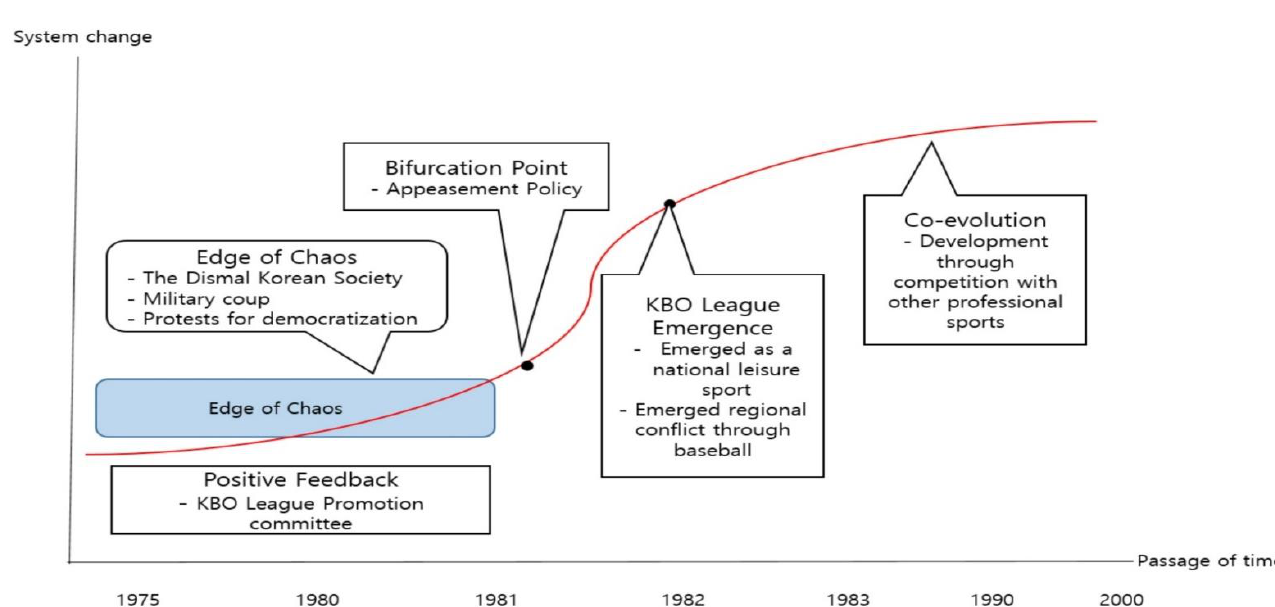
Figure 1. The emergence process of the KBO league from the perspective of the complex system paradigm.